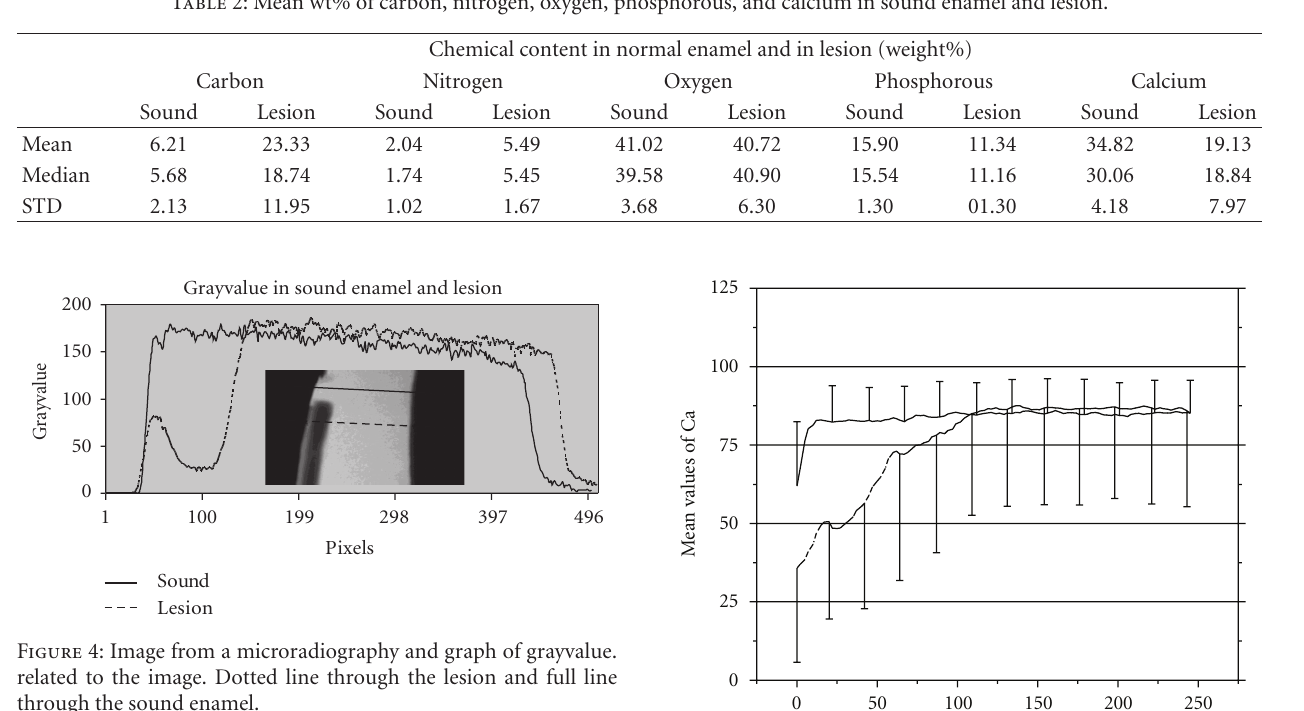
Table 2: Mean wt% of carbon, nitrogen, oxygen, phosphorous, and calcium in sound enamel and lesion.